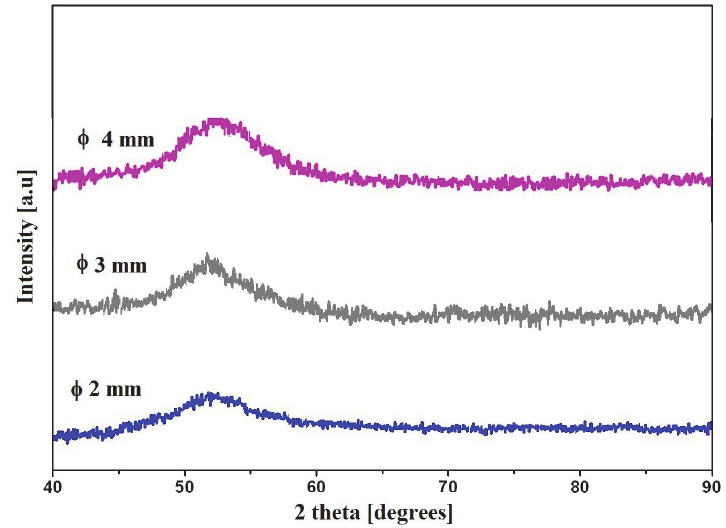
Figure 1: X-ray diffraction pattern of the Fe 36 Co 36 B 19 Si 5 Nb 4 BMGs rods with diameters of  =2, 3 and 4